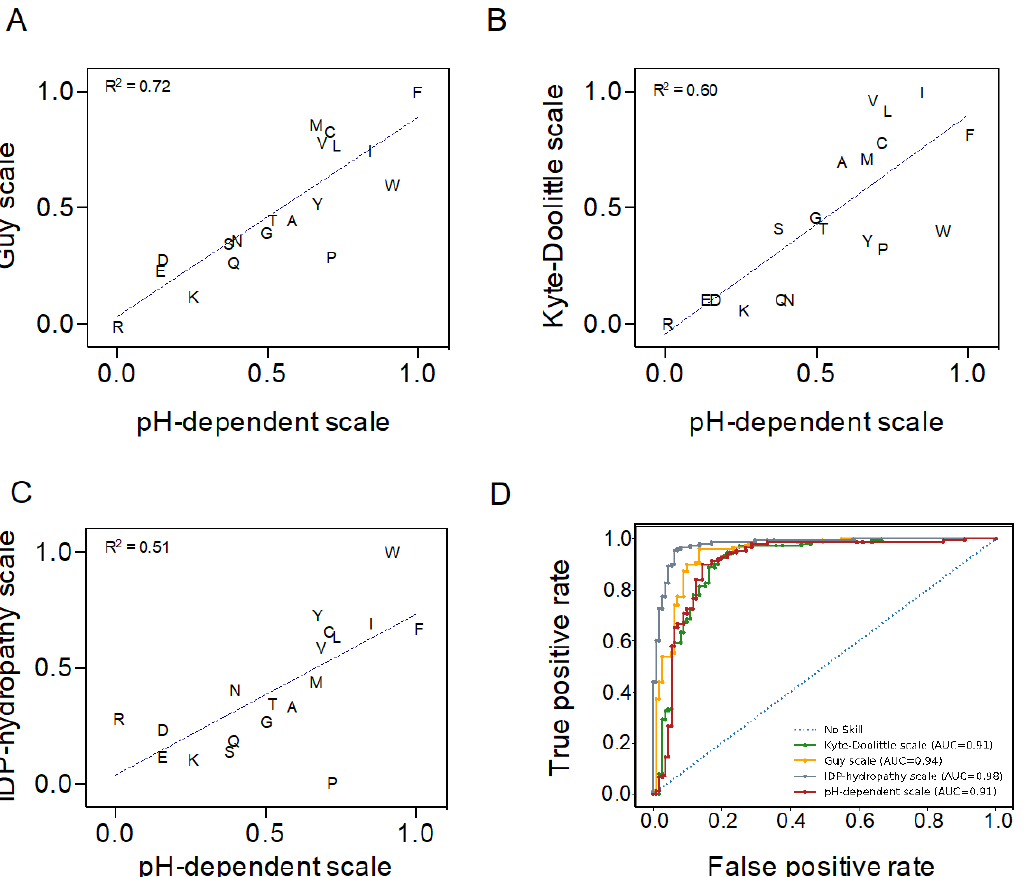
Figure 1. Comparison of four di ff erent hydropathy scales at pH 7.0. Correlation between pH-dependent scale and ( A ) Guy, ( B ) Kyte–Doolittle, and ( C ) IDP–hydropathy scales. Letters correspond to the amino acid one-letter code. Hydropathy values are normalized between 0 and 1, corresponding to the minimum and maximum values for each scale. The R 2 value of the linear regression is shown in each graph. ( D ) Receiver Operating Characteristic curves showing the performance of the four scales in discriminating a dataset of fully disordered ( n = 111) and single-chain folded ( n = 150) proteins.